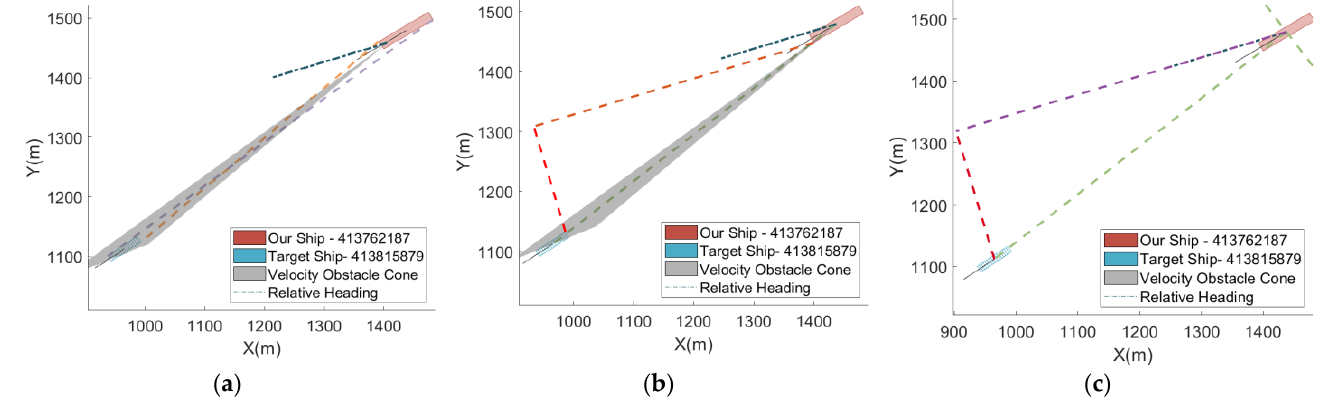
Figure 15. Comparison of DVOI/TVOI and CPA in Case 2. ( a ) The absolute velocity obstacle cone used to calculate DVOI, ( b ) the relative velocity obstacle cone used to calculate TVOI, ( c ) used to calculate DCPA and TCPA. Table 5. Risk assessment results of Case 2.